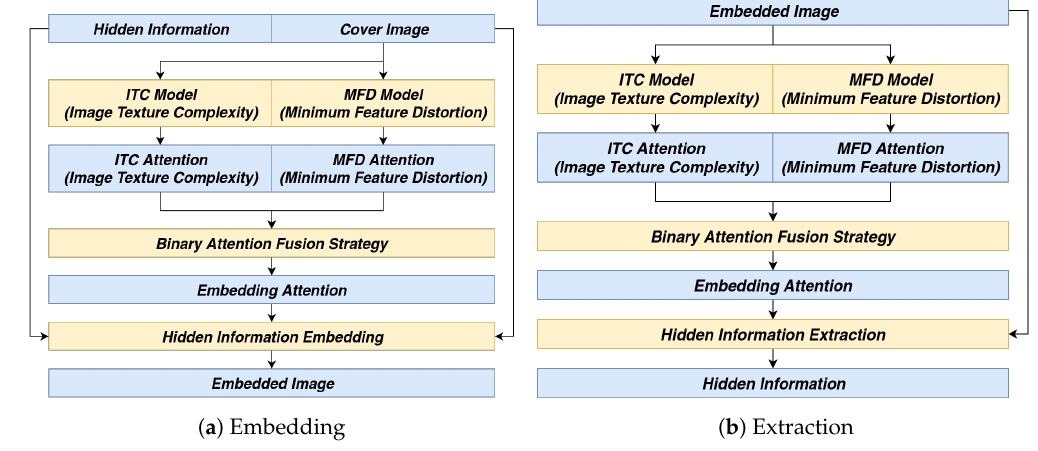
Figure 2. The embedding and extraction